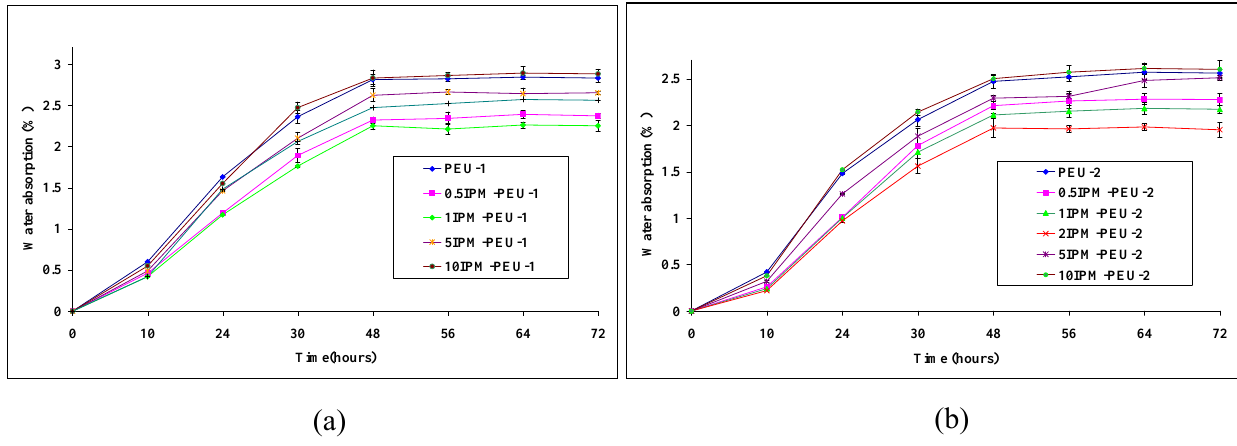
Figure 8. Water absorption of (a) PEU-1 series, (b) PEU-2 series after 72 hours soaking in deionised water at 37